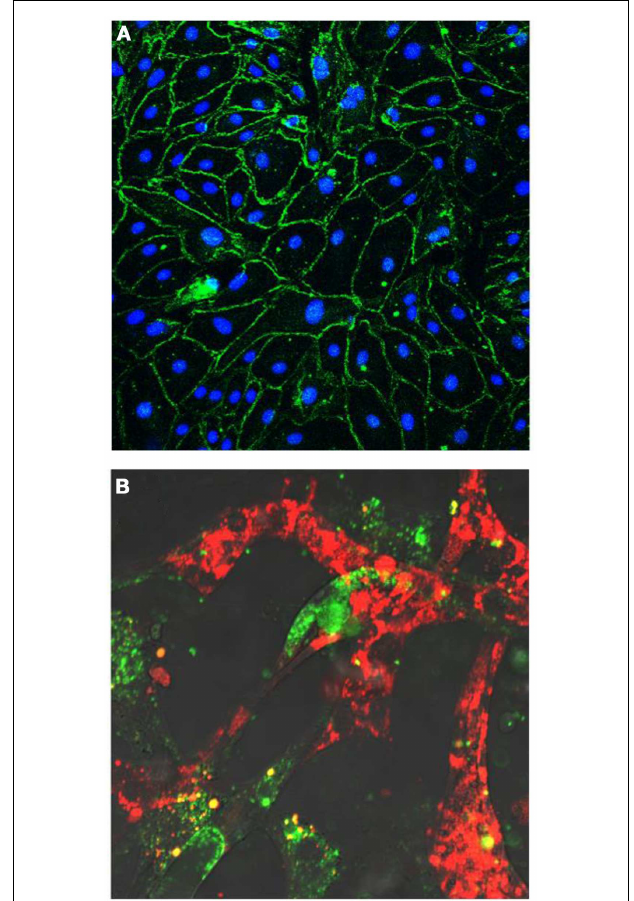
FIGURE 6 | (A) Human endothelial colony-forming cells (ECFCs) grow in culture as a cell monolayer and disclose a cobblestone appearance. Cells form tight junctional complexes, shown by Z0-1 staining in green. Nuclei labeled in blue with DAPI. (B) Human endothelial colony-forming cells (ECFCs) (labeled in red) form tube-like structures with retinal microvascular endothelial cells (labeled in green) in a 3D Matrigel in vitro model.